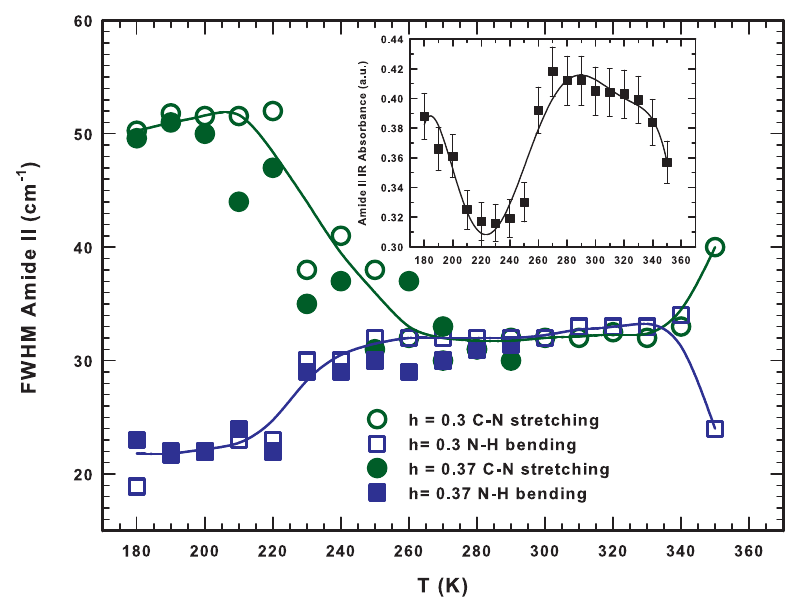
Figure 8. The Full Width at Half Maximum (FWHM) of the C–N stretching (1520 cm − 1 ) and N–H bending (1540 cm − 1 ) contribution of the Amide II band as a function of the temperature. The inset reports the total area of the whole band. Solid lines are a guide for the eye. Figure adapted from Reference